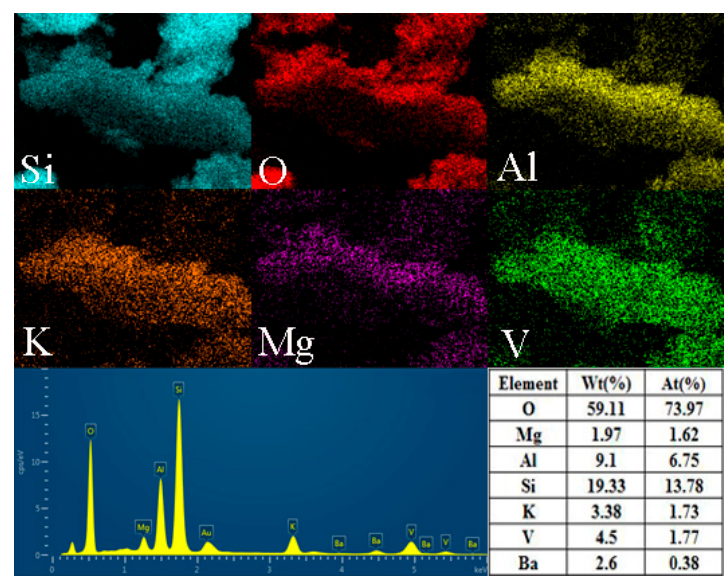
Figure 2. Scanning electron microscopy (SEM) images with energy disperse X-ray spectrometry (EDS) element mapping of the raw ore and the elemental weight percent (Wt(%)) and atoms percent (At(%)) at point i.